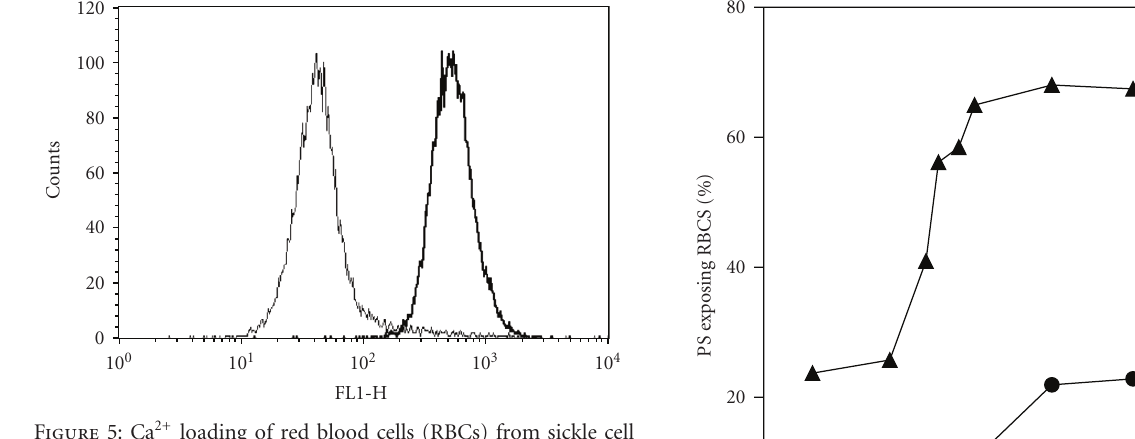
Figure 5: Ca 2+ loading of red blood cells (RBCs) from sickle cell patients. RBCs were loaded with the Ca 2+ fluorophore fluo-4 (see Methods). They were then incubated for 30min in the absence (left—thin line) or presence (right—thick line) of bromo-A23187 at an extracellular [Ca 2+ ] of 1 μ M. Results are presented as histogram of fluorescence of a single experiment representative of 3.